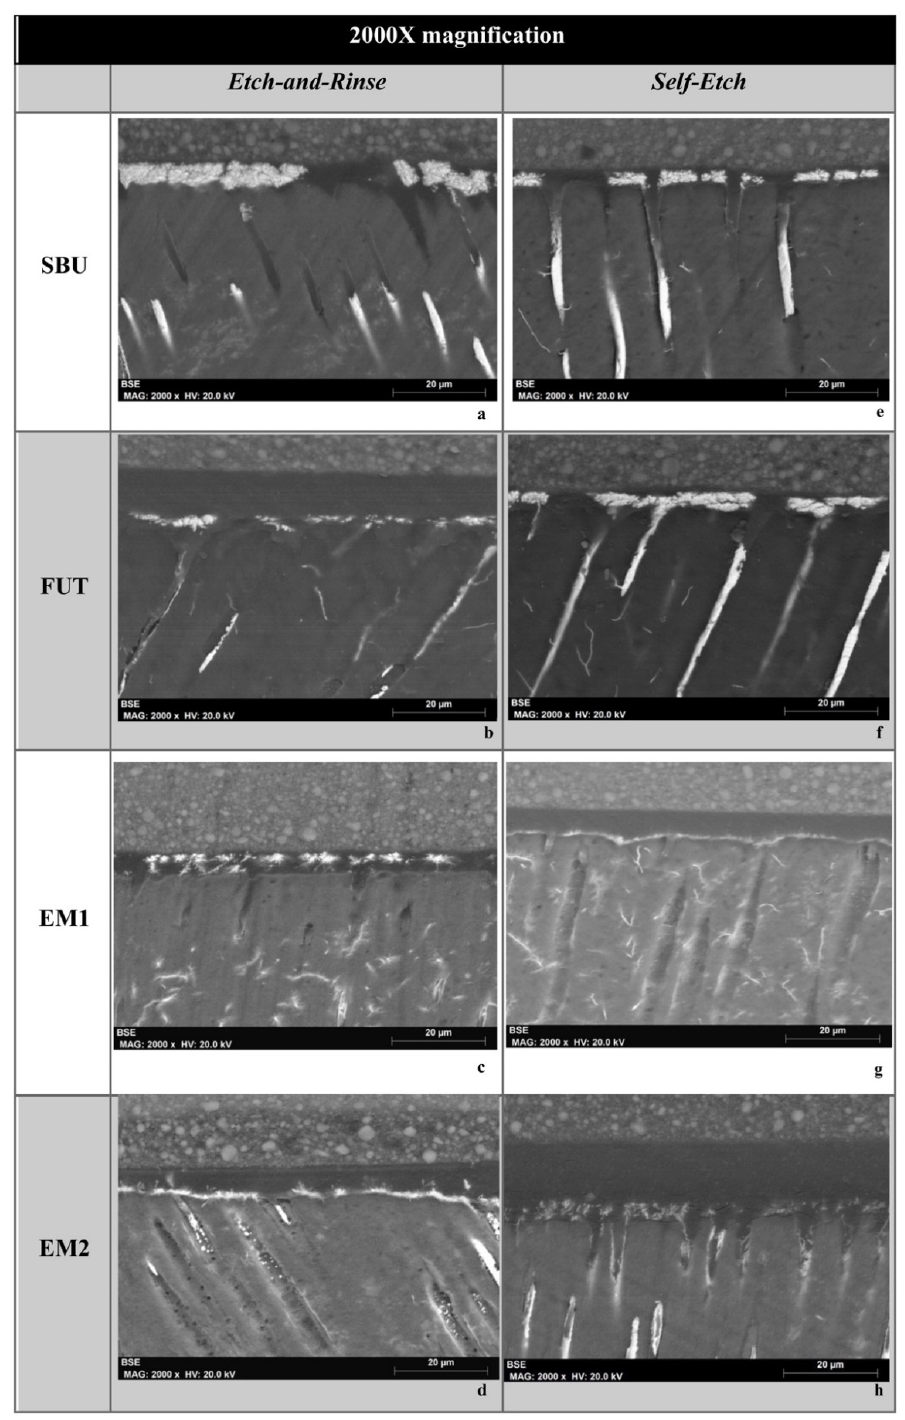
Figure 5. FEG-SEM images of the ER/SE adhesive interfaces, at 2000 × magnification. ( a ) shows SBU in etch-and-rinse, while ( e ) shows SBU in self-etch mode, ( b ) shows FUT in etch-and-rinse and ( f ) in self-etch, ( c ) shows experimental EM1 in etch-and-rinse and ( g ) in self-etch and ( d ) EM2 in etch-and-rinse while ( h ) in self-etch mode. Silver nitrate deposit zones on the adhesive interface correspond to white spots with a granular appearance. Similarly, to the image above, it is possible to discern that ER showed higher nanoleakage expression than SE strategies. Experimentals EM1 and EM2 show less pronounced nanoleakage under SE compared to